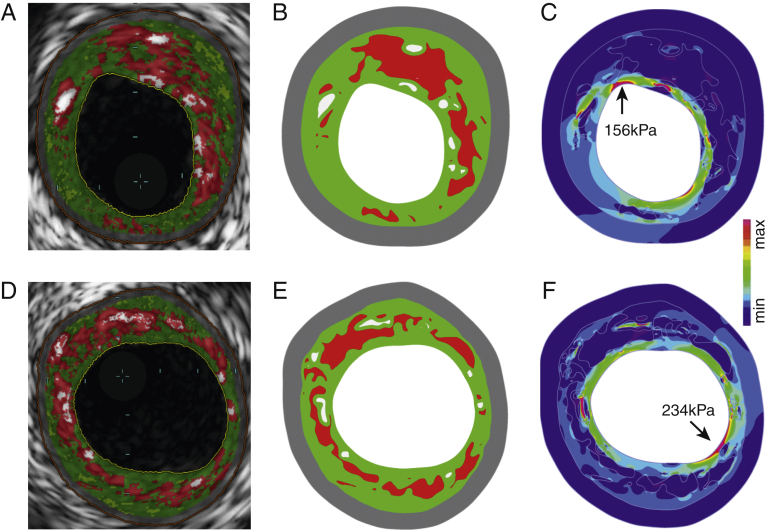
Illustrative Examples for Stepwise Calculation of Plaque Structural Stress From IVUS-VH Through Finite Element Analysis(A and D) IVUS-VH images showing necrotic core (red), dense calcium (white), fibrofatty tissue (light green), and fibrous (green). (B and E) Reconstructed plaque geometry and segmented plaque components used for finite element analysis. (C and F) Plaque structural stress band plots identifying regions with high stress concentration (arrows indicate areas of high stress at the plaque/lumen boundary). IVUS-VH = intravascular ultrasound-virtual histology.